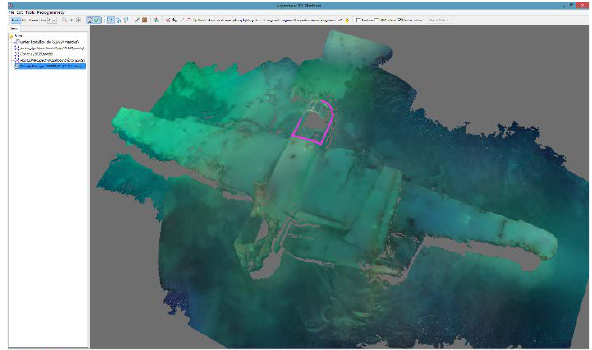
Figure 5 A geodesic path enclosing an amphora (Junker